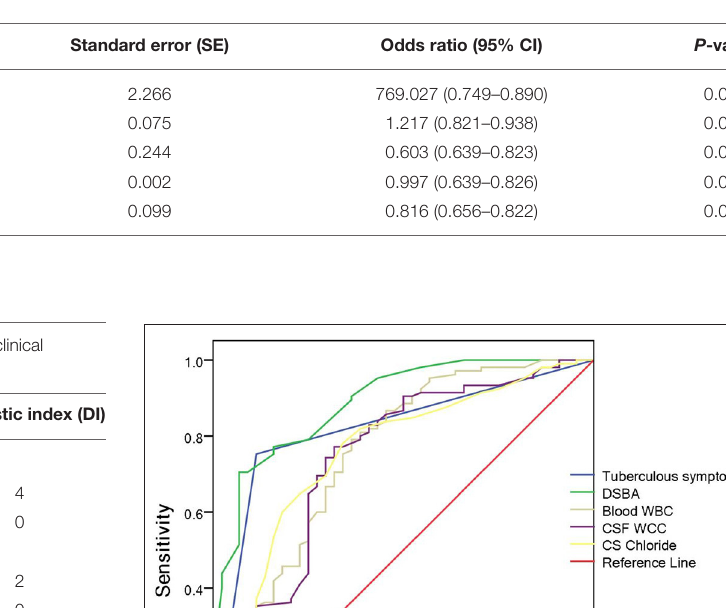
TABLE 4 | Original multivariate logistic regression analysis.